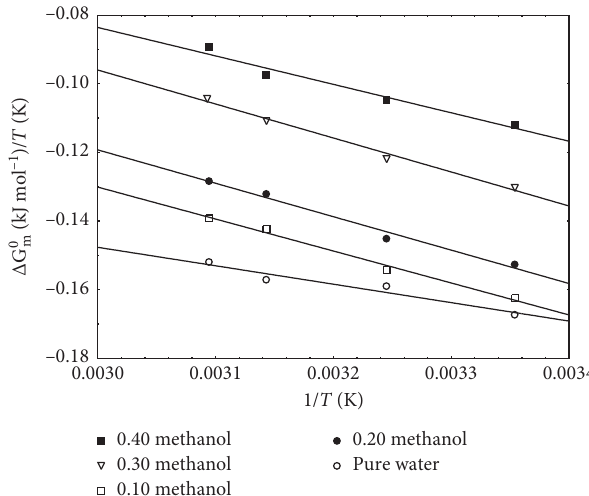
Figure 4: Variation in c / c CTAB solution with the volume o cmc fraction of methanol: square (298.15 K), triangles (308.15K), closed circles (318.15K), and closed squares